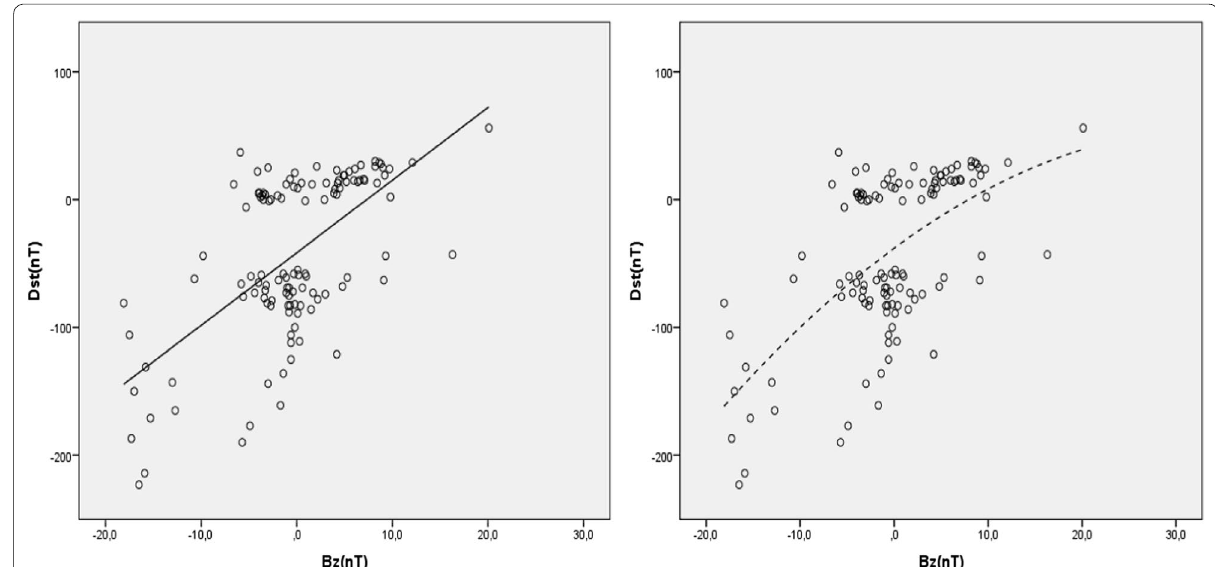
Fig. 3 Linear and quadratic relation of Dst and B z . In Fig. 3, the linear and quadratic relationships of the magnetic field component B z with the Dst index are